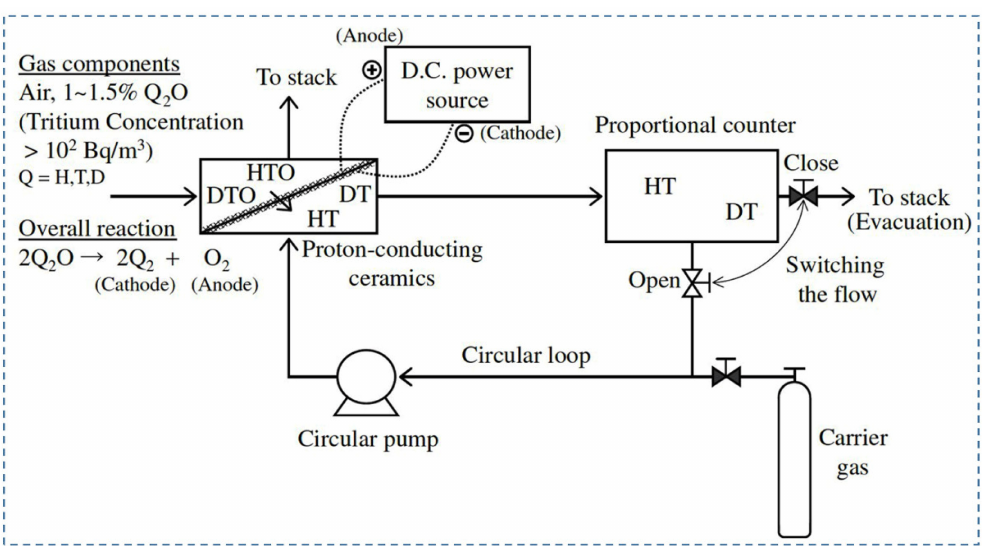
Figure 3. A schematic representation of the tritium monitor in combination with the proton- conducting material. Reprinted with permission from Ref. [70]. Copyright 2004 Taylor &